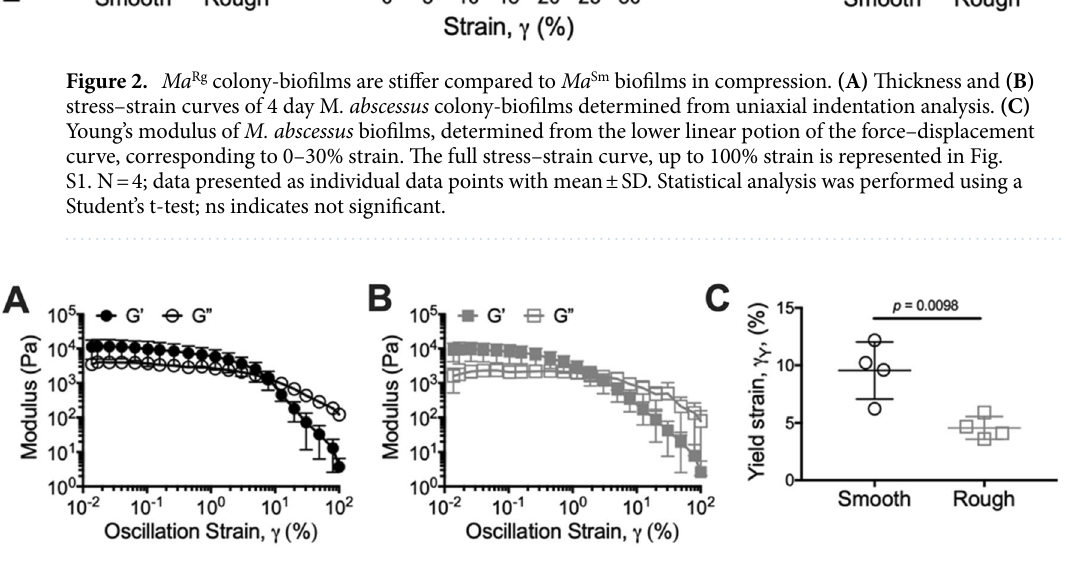
Figure 3. Ma Sm colony-biofilms are more pliant than Ma Rg biofilms in shear. Strain sweep profiles of 4 day (A) Ma Sm and (B) Ma Rg colony-biofilms. N = 4; data presented as mean ± SD; G’ = storage modulus and G” = loss modulus. (C) Yield strain of M. abscessus colony-biofilms determined from (A) and (B) . N = 4; data presented as individual data points with mean ± SD. Statistical analysis was performed using a Student’s